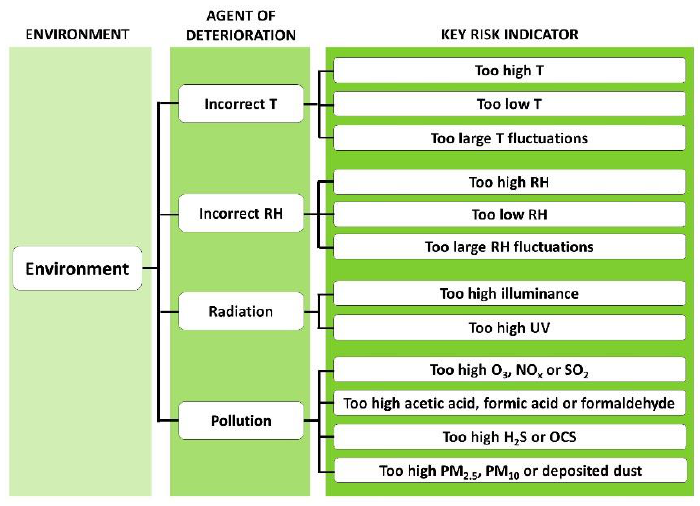
Figure 1. Schematic overview of the different levels by which the environmental appropriateness for heritage conservation are evaluated on. Abbreviations: RH, relative humidity; T, temperature; OCS, carbonyl sulfide.